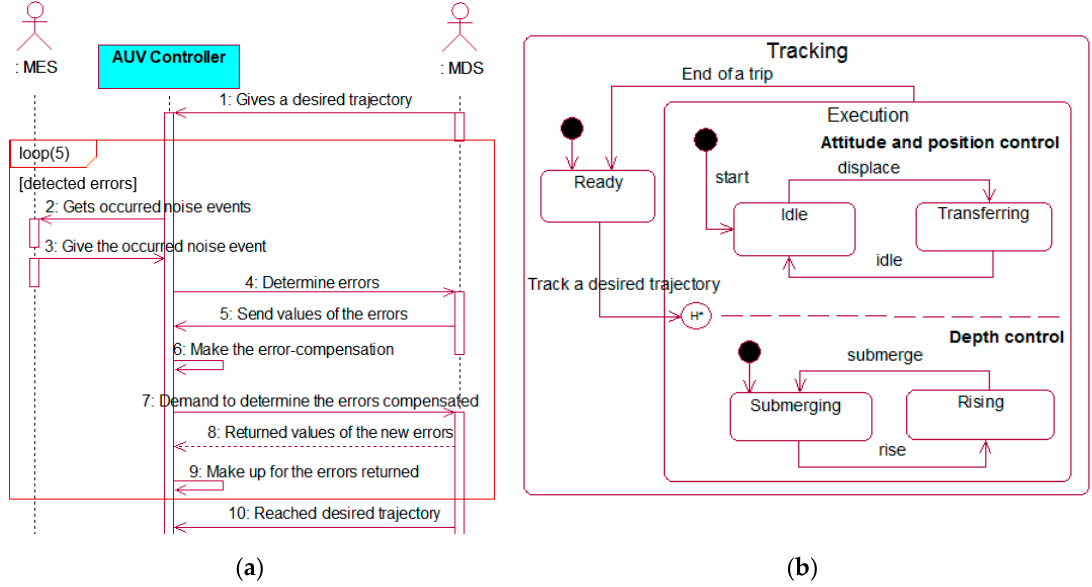
Figure 3. ( a ) Desired trajectory-tracking scenario, and ( b ) local state machine for performing the “ track a desired trajectory ” use case.